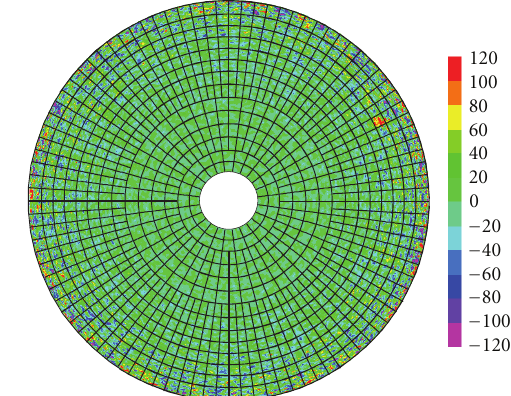
Figure 10: Map of the retrieved reflector surface for a deformation of 100 μ m of the panel under test. SNR = 44 dB. The color bar is in unit of μ